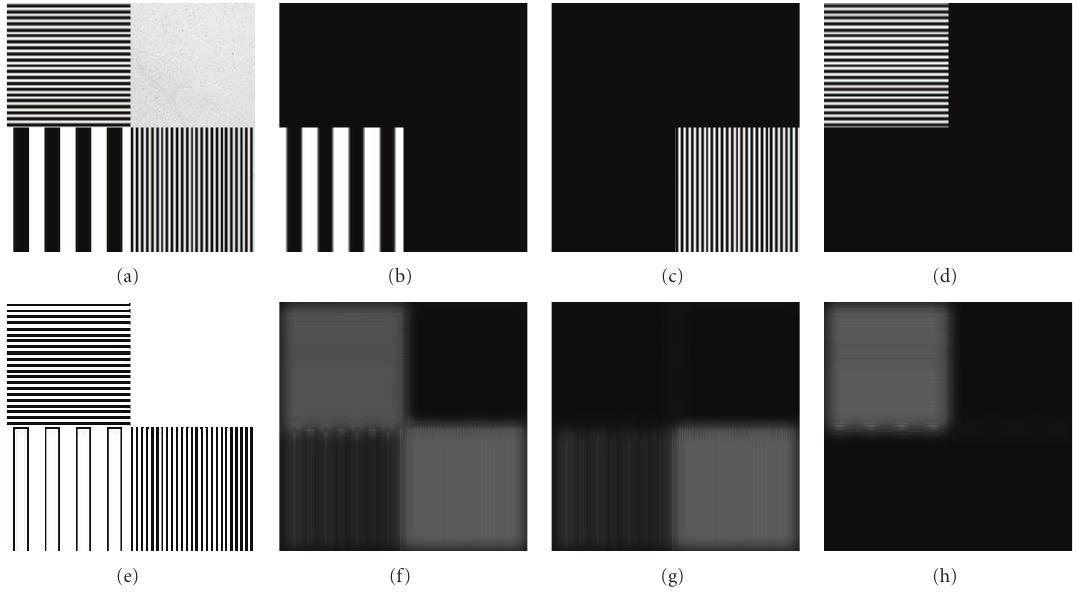
Figure 1: Extraction of various embedded textures using the PDE transform. (a) shows the original image composed of various horizontal and vertical textures. (b)–(d) show the three texture patterns extracted by applying the PDE transform, one at each time. (e) shows the edge mode obtained by applying the PDE transform to (a). (f) shows the variance of the local variation of the image mode function (e). (g) and (h) show the projection, or average, of the variance in (f) along x - and y -direction,